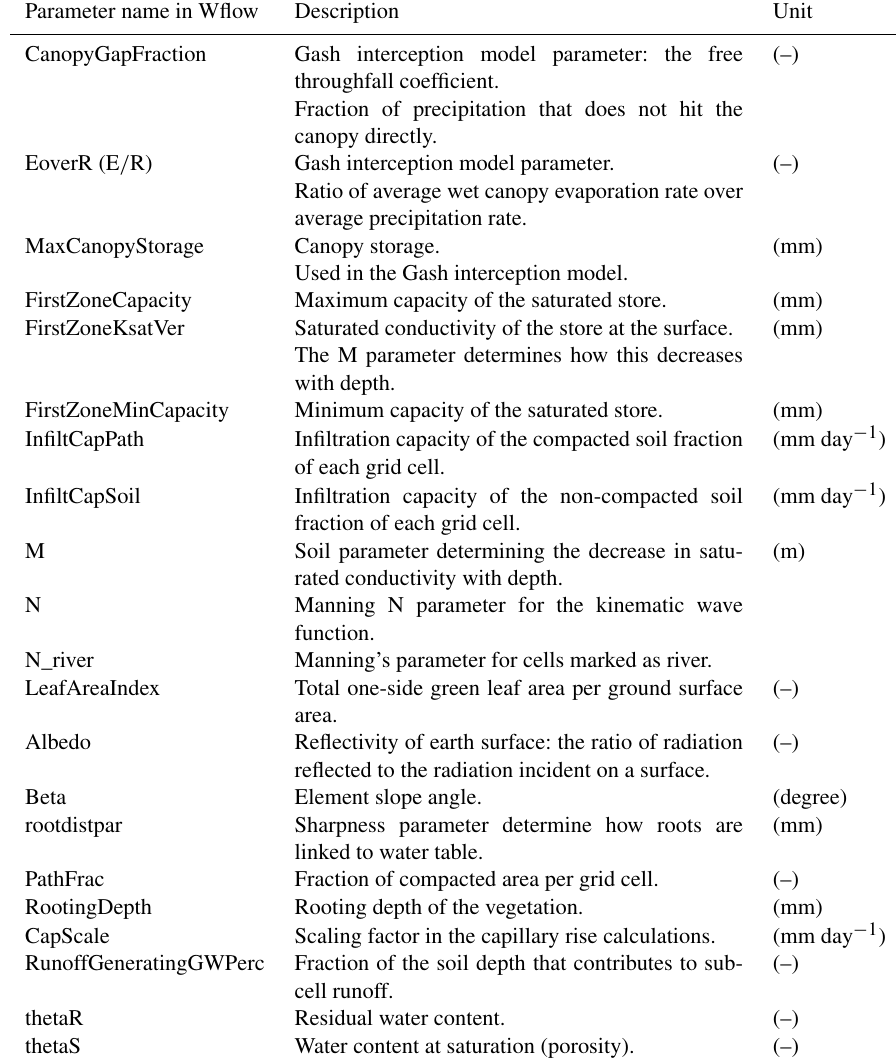
Table B1. Wflow model parameter’s